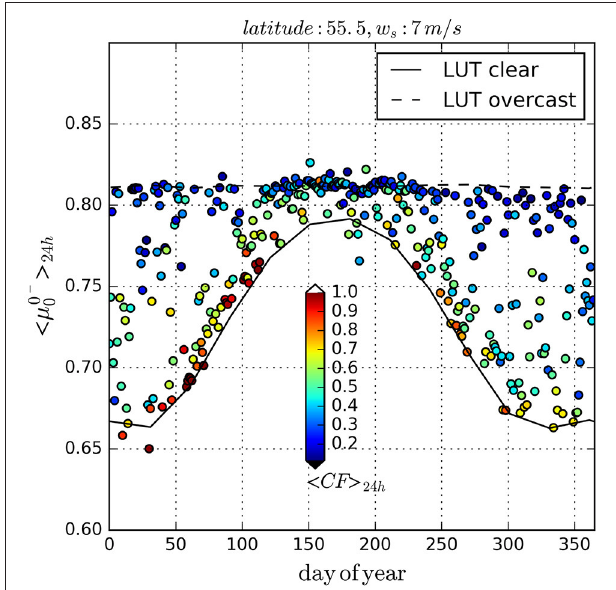
FIGURE 14 | Mean cosine PAR for all the days of 2011 (dots), for a particular latitude and wind speed, as well as predicted values for clear sky (solid line) and totally overcast situations (dashed lines). The color of the dots is a function of the cloud factor.